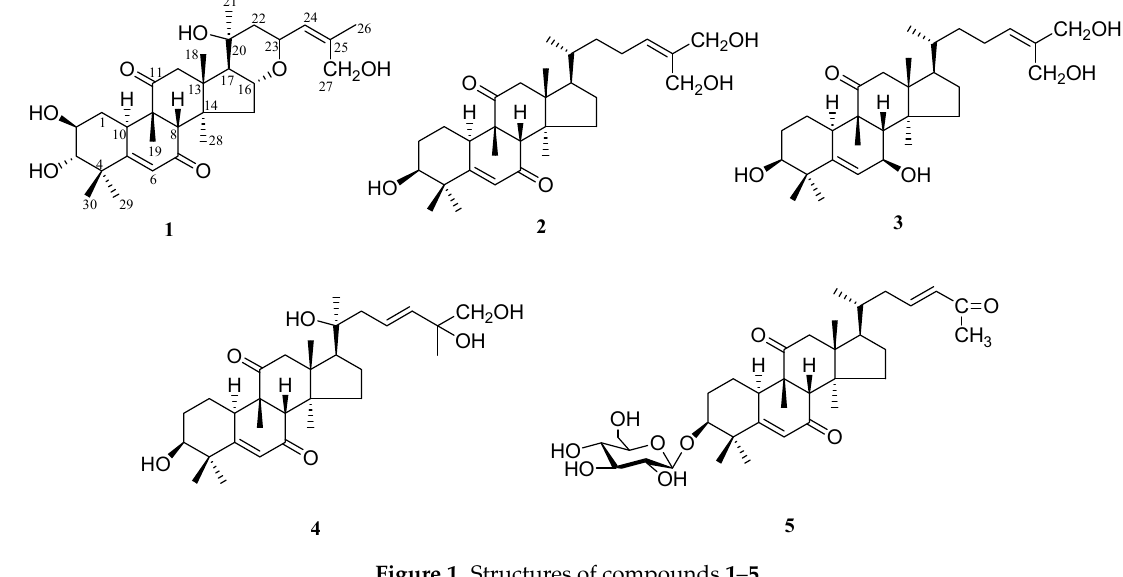
Figure 1. Structures of compounds 1 – 5 .